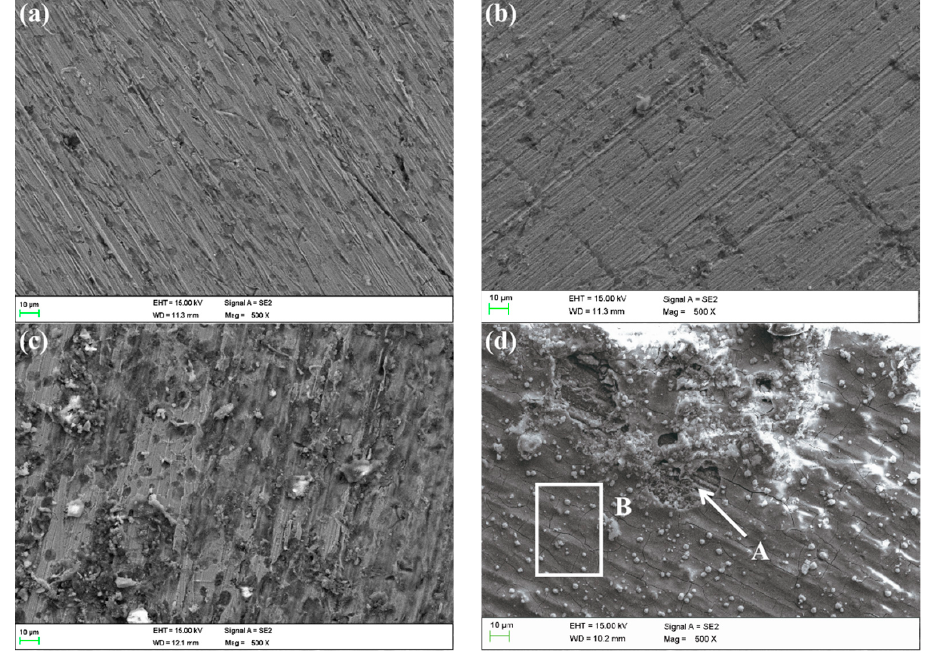
Figure 17. SEM morphology of WZ surface in different flowing rates of seawater: ( a ) 0 m/s, ( b ) 1 m/s, ( c ) 3 m/s, ( d ) 5 m/s .